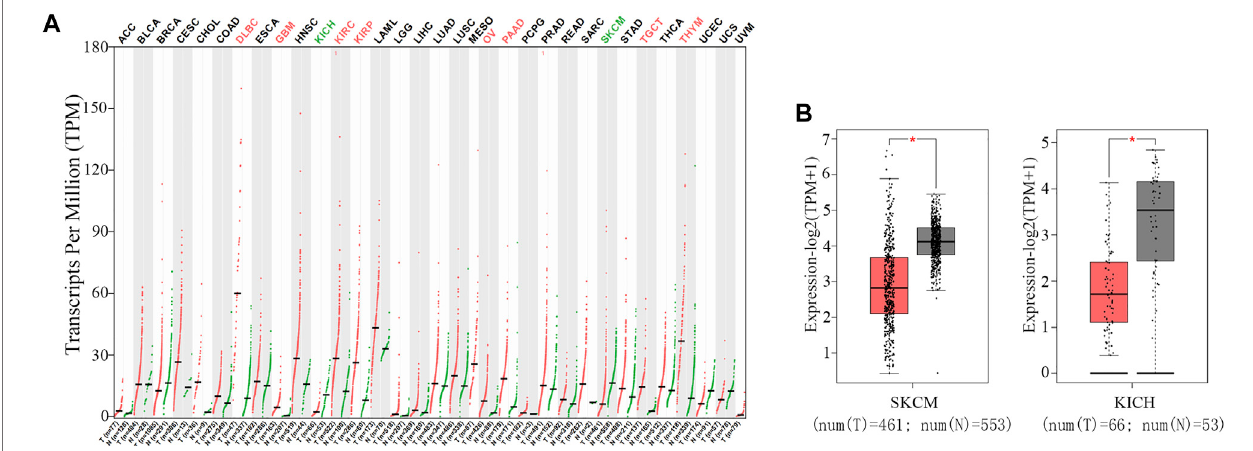
FIGURE2| ExpressionofTNFAIP8inbothtumorandnormaltissuesofmultiplecancertypes. (A) ThemRNAexpressionoftheTNFAIP8expressionpro fi leacross alltumorsamples(reddots)andpairednormaltissues(greendots).The y -axisatthetopshowsthenamesofthecancertypes(redindicatesthatTNFAIP8isupregulated in tumor samples, green indicates downregulated, and black indicates non-signi fi cance). The y -axis at the bottom shows the sample size oftumor and normal tissues in each cancer. (B) The mRNA expression of TNFAIP8 in SKCM and KICH samples (tumor samples in red from TCGA, and normal samples in gray from GTEx). * p <